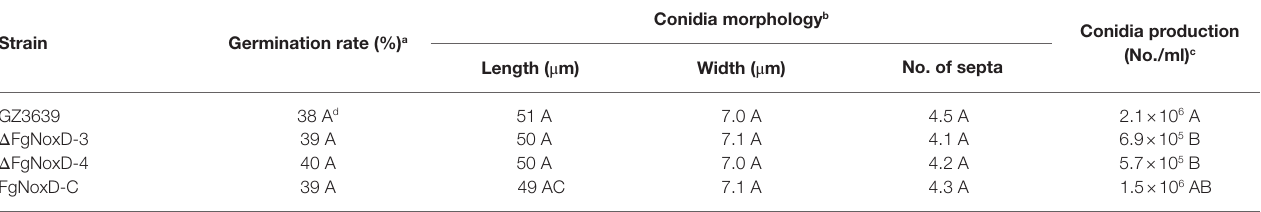
TABLE 2 | Asexual development and conidia production.